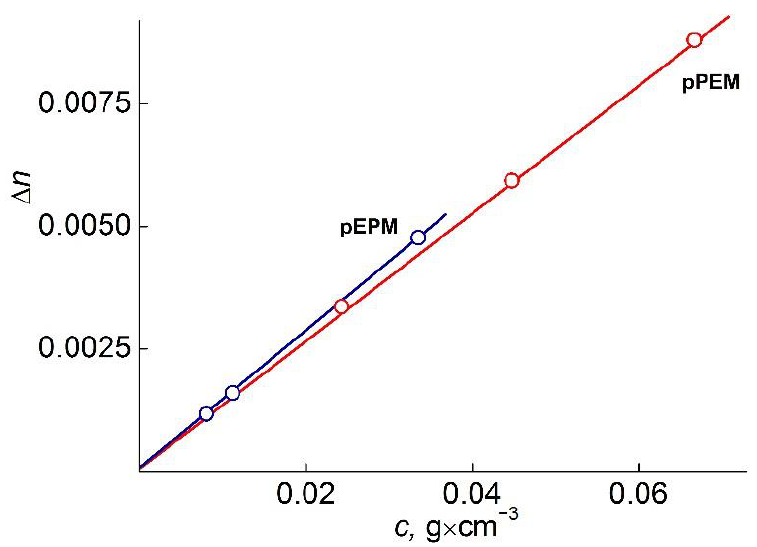
Figure 6. Dependence Δn vs. concentration for pEPM and pPEM in acetonitrile.